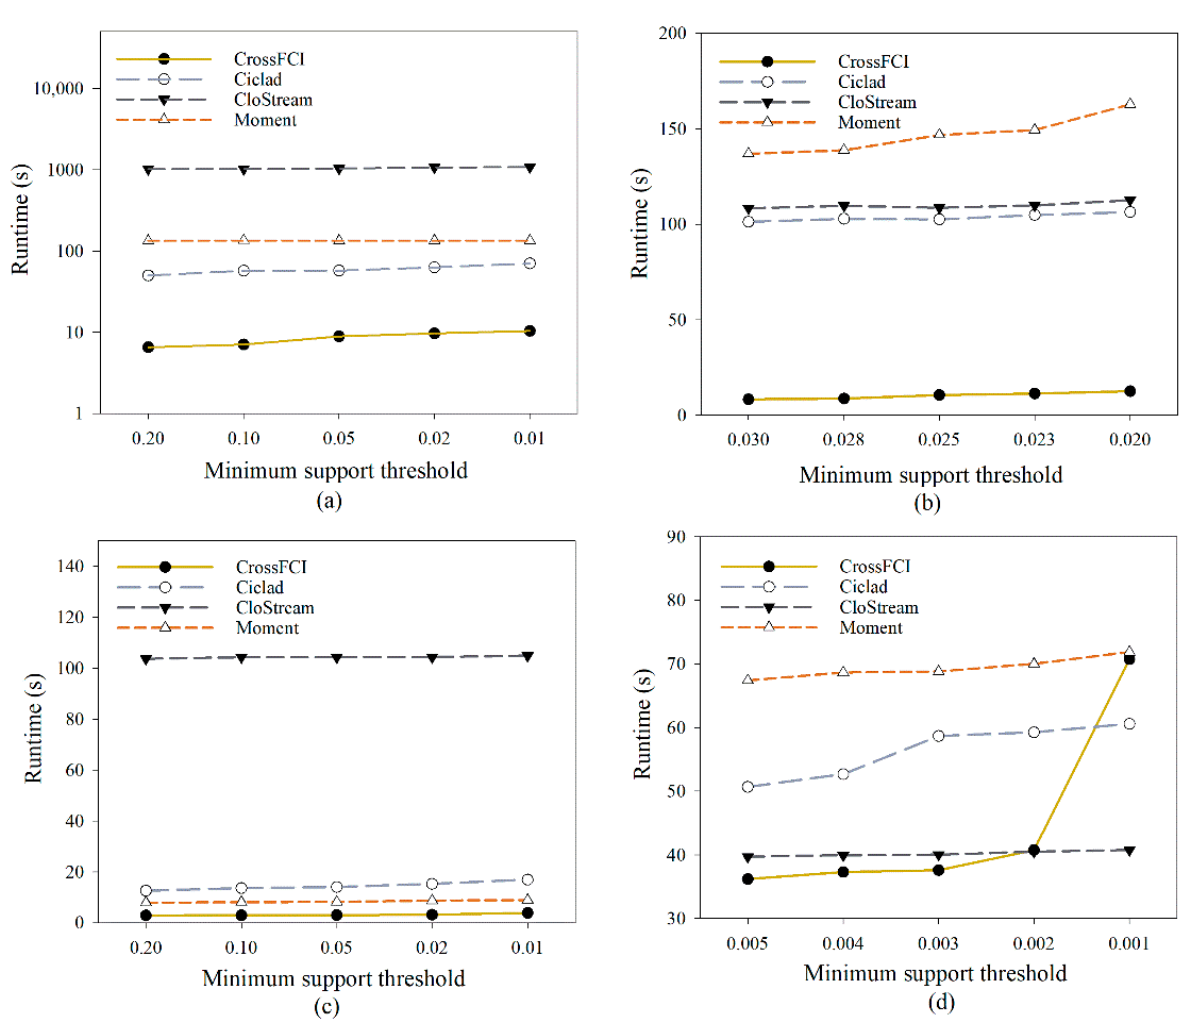
Figure 8. Efficiency comparison of different FCIM algorithms. ( a ) Results on Mushroom dataset. ( b ) Results on Synth2 dataset. ( c ) Results on Retail dataset. ( d ) Results on Synth dataset.